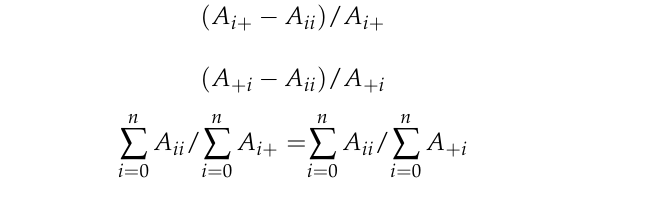
Table 2. Similarity matrix to assess the accuracy of the upscaled